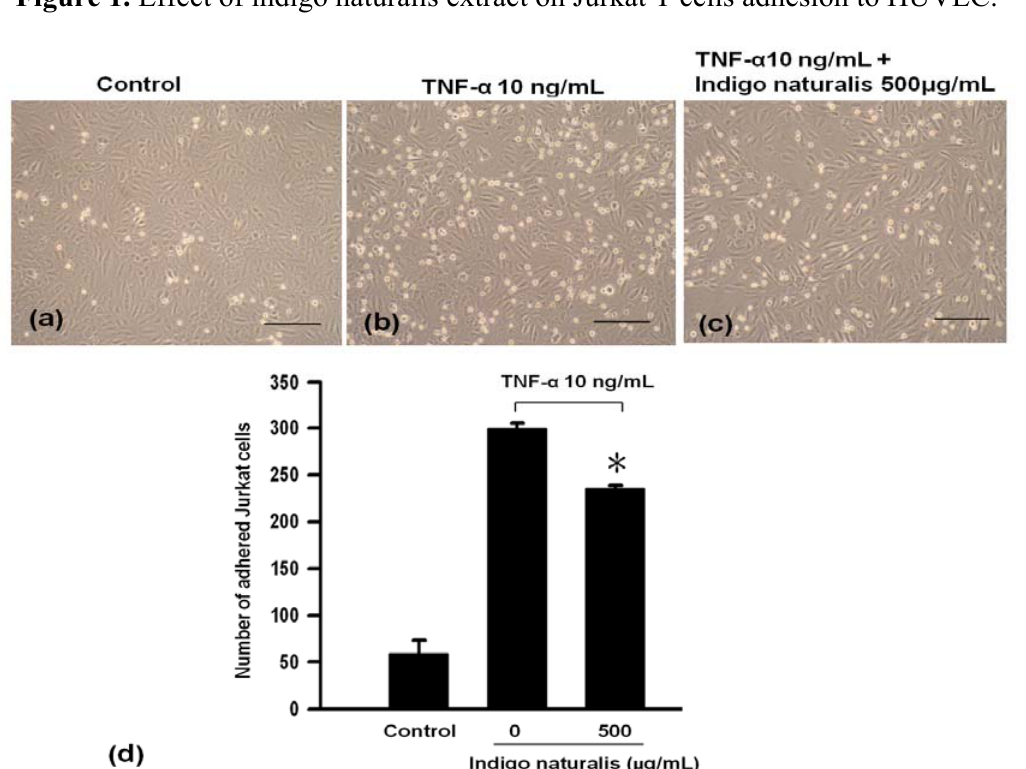
Figure 1. Effect of indigo naturalis extract on Jurkat T cells adhesion to